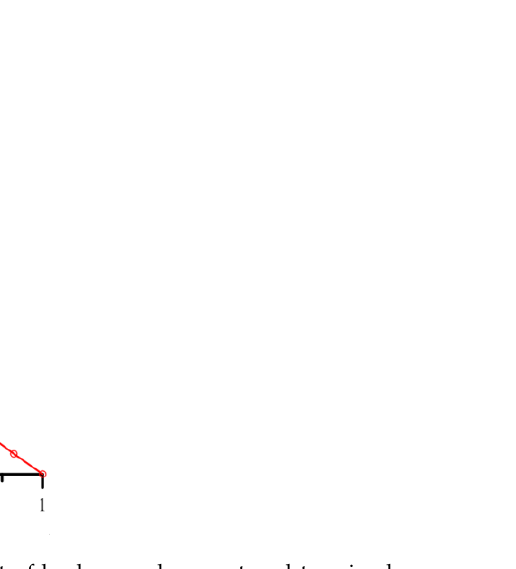
Figure 3 . Experimental results of the effect of background current and terrain slope on coastal ocean waves.